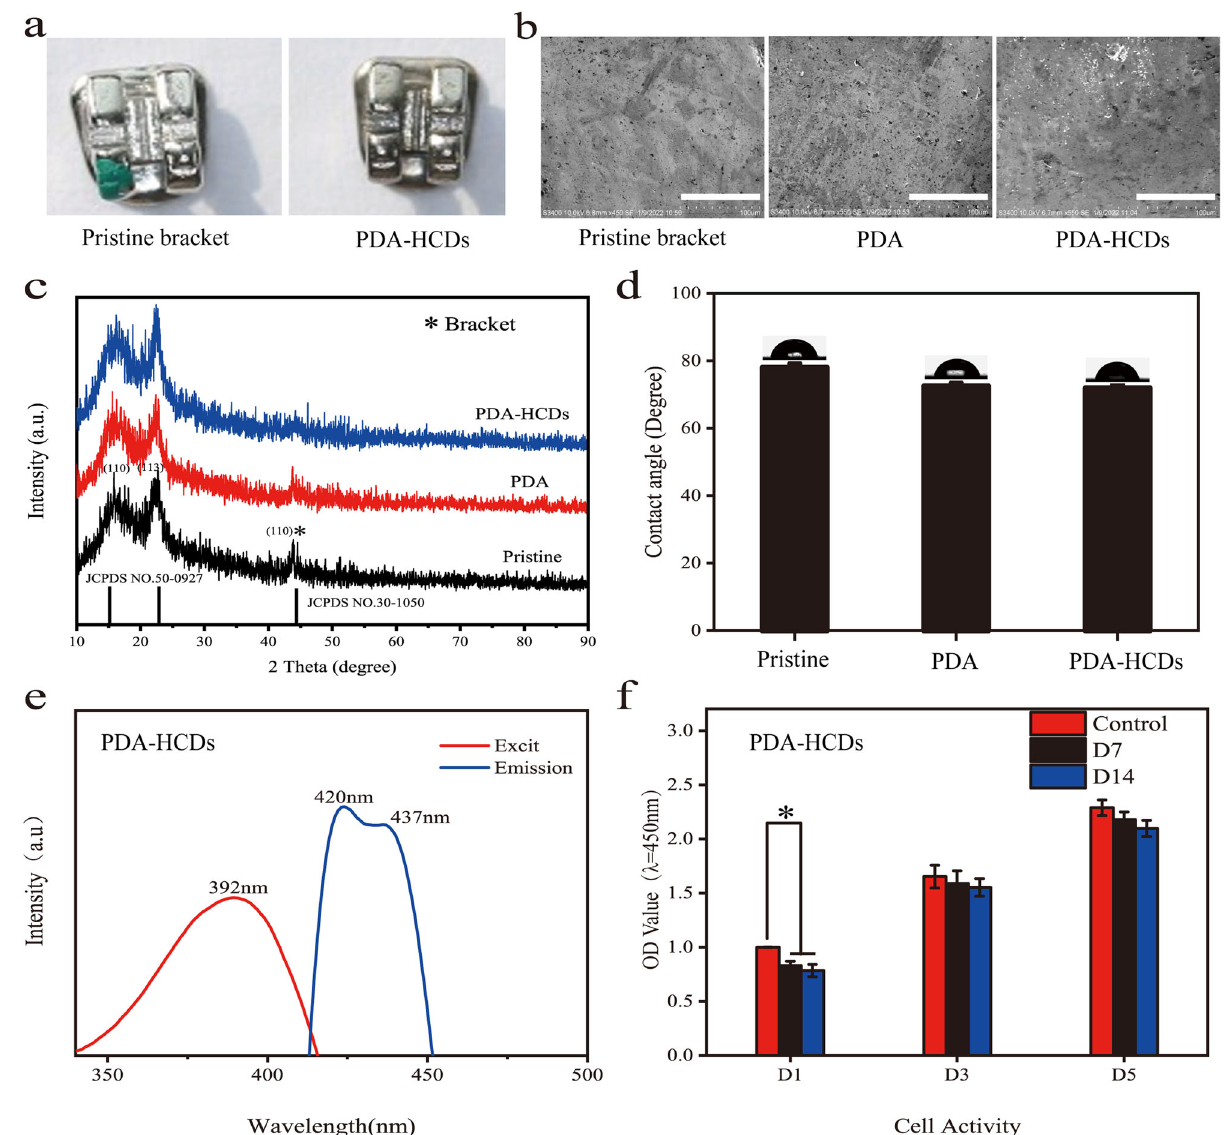
Fig. 4 Characterization of PDA-HCDs coatings on the substrate sur- face. a Photos of the pristine bracket (left) and the bracket that was modi fi ed with the PDA-HCDs coating (right). b , c Analyses of SEM ( b ) and XRD ( c ) for a pristine bracket, PDA-bracket, PDA-HCDs bracket. d Water contact angle measurements for these substrates. e Analyses of excitation and emission spectra for the PDA-HCDs